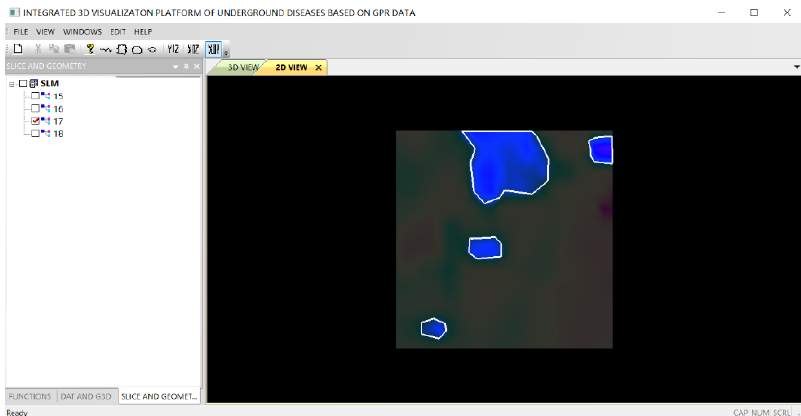
Figure 11. Pick geohazard information.